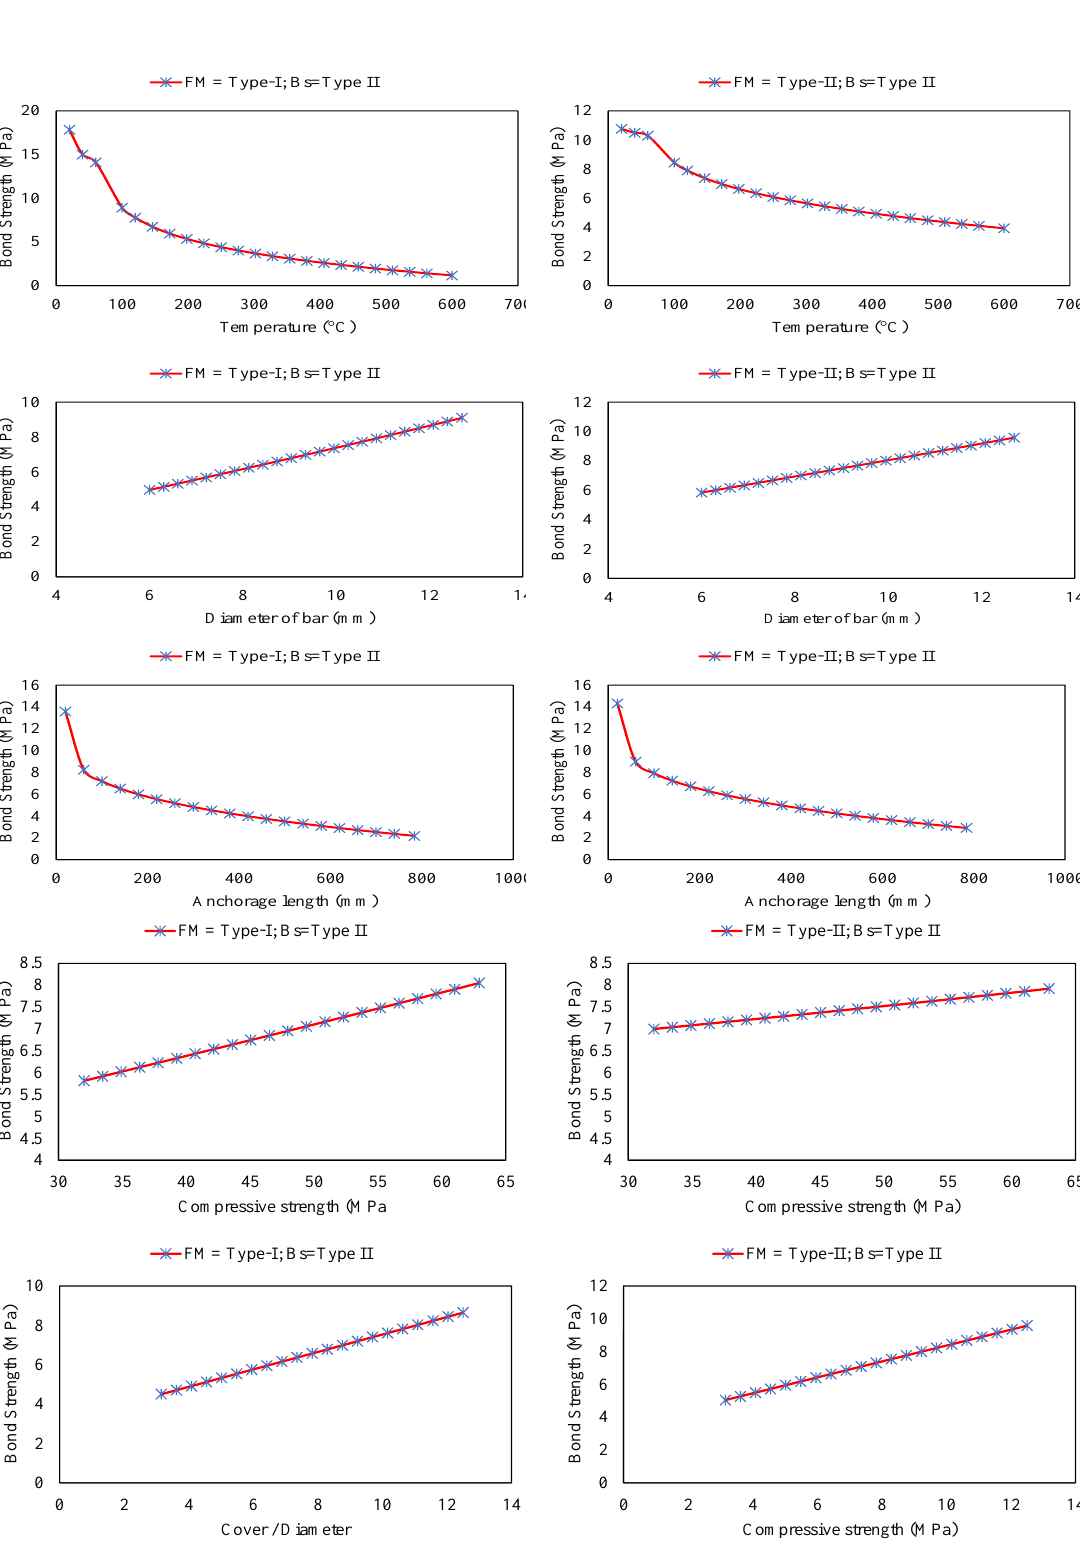
Figure 9. Parametric study of the GEP model showing variation of bond strength with change in input variable for Type I (debonding) and Type II (pull-out) failure modes corresponding to Type-II bar surface (Ribbed).